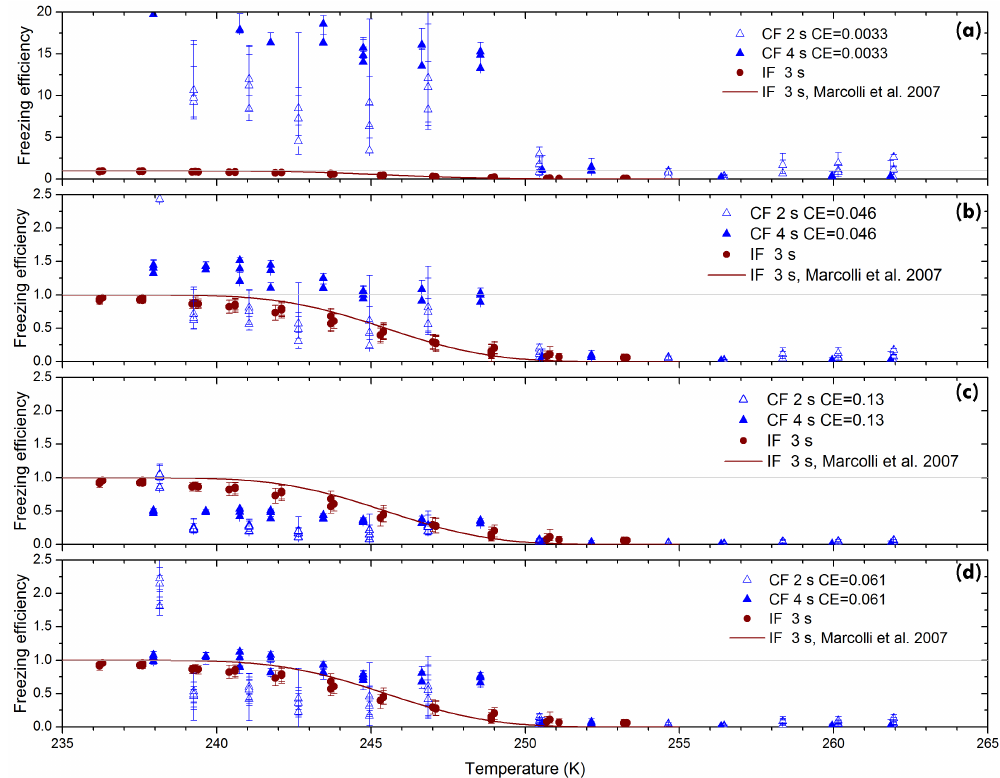
Figure 5. Freezing efficiency for 800nm ATD particles with a concentration of 1000cm − 3 calculated with four different assumptions for CE: panel (a) , with theoretical CE from Wang et al. (1978) and Park et al. (2005); panel (b) , with 14 × CE from panel (a) (see text for details); panel (c) , with CE = 0 . 13 (applying the value for 200nm AgI particles for all particle sizes); panel (d) , with CE = 0 . 061, which shifts collision efficiencies close to 1. Filled triangles show contact freezing for 4s residence time in the CLINCH chamber; the open triangles are for 2s residence time. Each triangle represents an independent measurement. Error bars represent the precision of the IODE detector. Brown circles show the freezing efficiency for immersion freezing of droplets in the IMCA–ZINC chamber for a 3s residence time. The brown lines show the FF calculated with the active site immersion freezing parameterization from Marcolli et al. (2007) evaluated for 800nm particles and a 3s residence time. The gray horizontal line indicates FE = 1. Note that the y scale in panel (a) is different from the ones in panels (b) , (c) and (d)